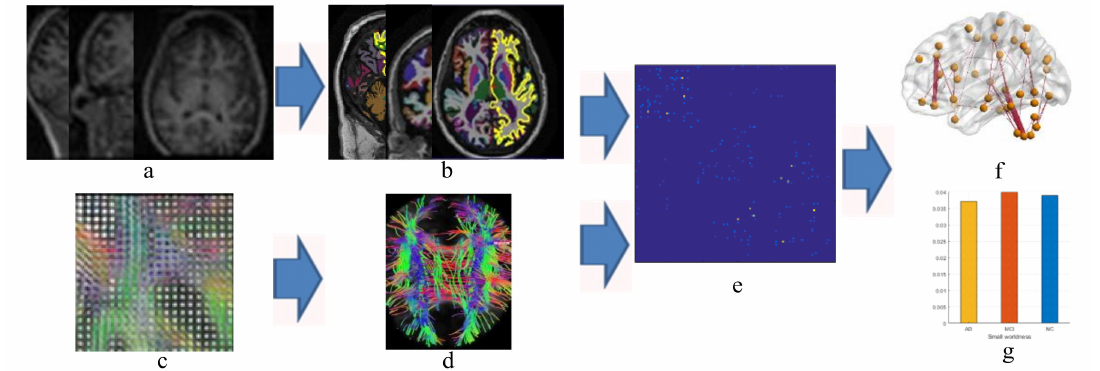
Figure 1. Flow chart to compute structural connectivity matrix and network analysis ( a ) magnetic resonance(MR) images, ( b ) partitioninto region of interests, ( c ) diffusiontensor imaging, ( d ) tractography, ( e ) structural connectivity matrix calculation, ( f ) brain network and ( g ) graph theoretical